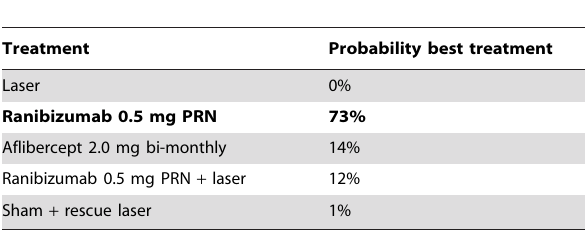
Table 3. Probability that each treatment is the most efficacious treatment in the network.